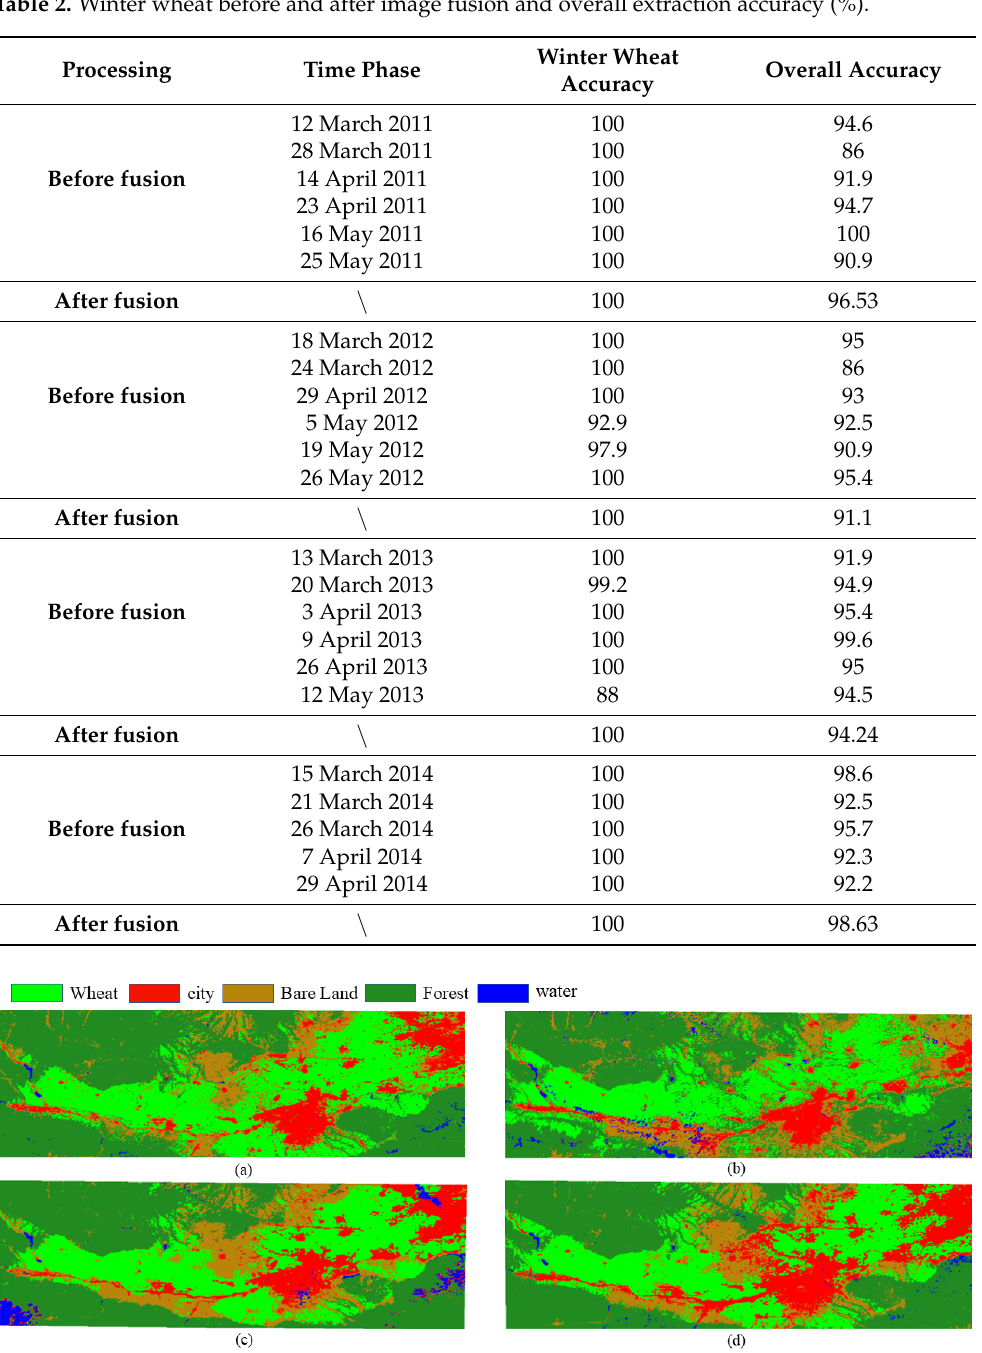
Figure 8. Plot of fusion results of RF classification methods from 2011 to 2014. ( a )A map of the fused distribution obtained by RF in 2011. ( b ) A map of the fused distribution obtained by RF in 2012. ( c ) A map of the fused distribution obtained by RF in 2013. ( d ) A map of the fused distribution obtained by RF in